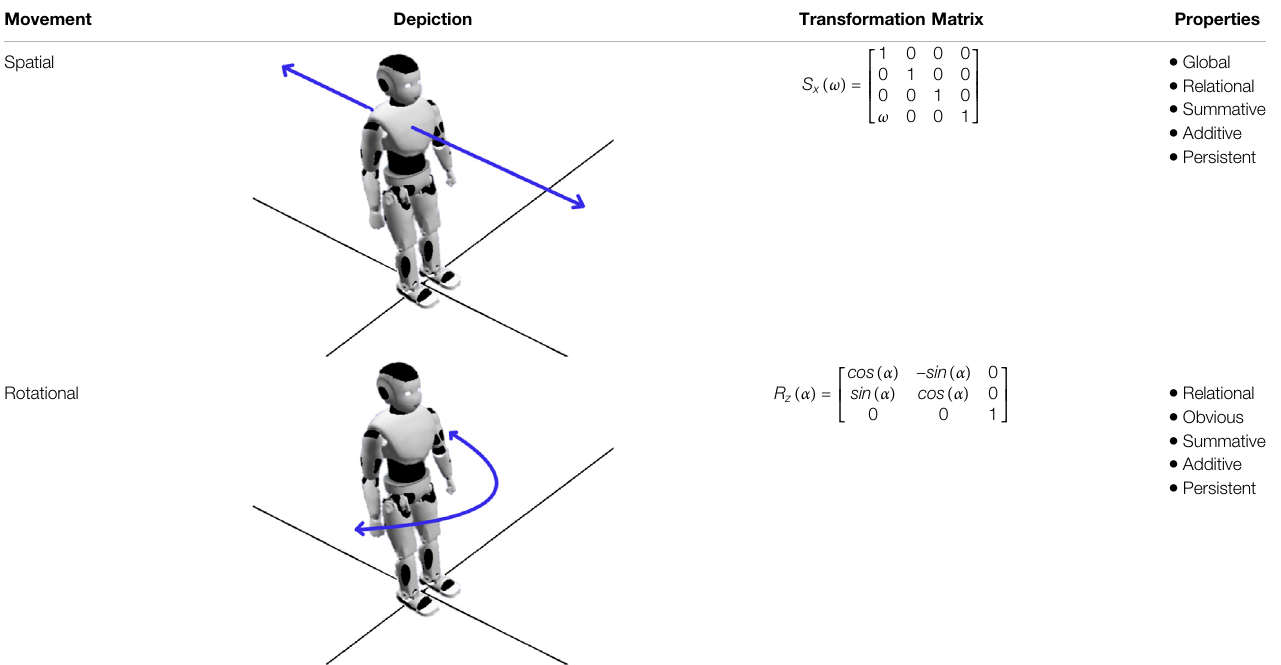
TABLE 3 | Depiction of the body movements Spatial and Rotational with their corresponding name, depiction with a physical robot, movement vector and properties in the respective columns. Movement Depiction Transformation Matrix Properties Spatial